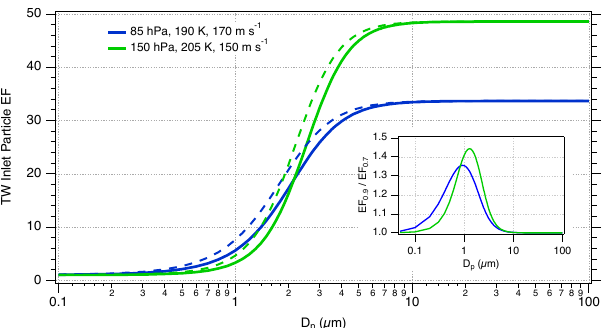
Figure 7. TW inlet particle aspiration enhancement factor (EF) as a function of particle diameter ( D p ) calculated using the formu- lation of Eq. (15) in Eddy et al. (2006) for the TW inlet geom- etry and assumed ice particle densities of 0.7gcm − 3 (solid) and 0.9gcm − 3 (dashed). The curves represent conditions near the trop- ical tropopause (approximately 17.6 km, blue) and near the bottom (approximately 14.4 km, green) of the typical NASA Global Hawk operational altitude range during the ATTREX mission. The inset plot shows the ratio EF 0 . 9 / EF 0 . 7 as a function of particle diameter to illustrate the effect of assumed particle density on the inlet